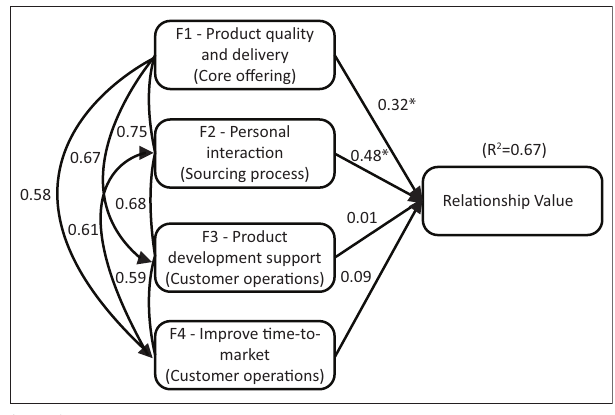
FIGURE 2: Results of the path analysis. Standardised coefficients are presented in the paths to relationship